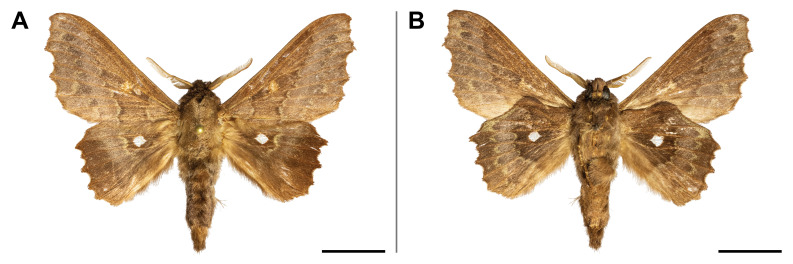
Mimopacha
tripunctata (Aurivillius, 1905). A. dorsal view; B. ventral view. The scale bar represents 1 cm.